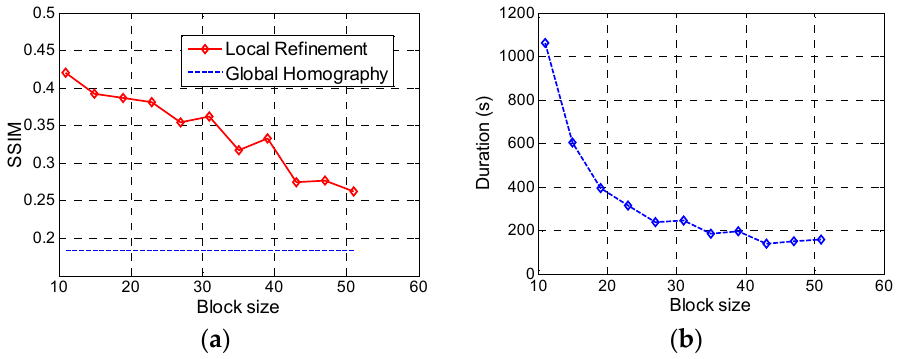
Figure 8. ( a ) Global SSIM between transformed and reference images vs. number of neighbor points, 𝑁 (cid:3012) . ( b ) Duration (s) vs. number of neighbor points,